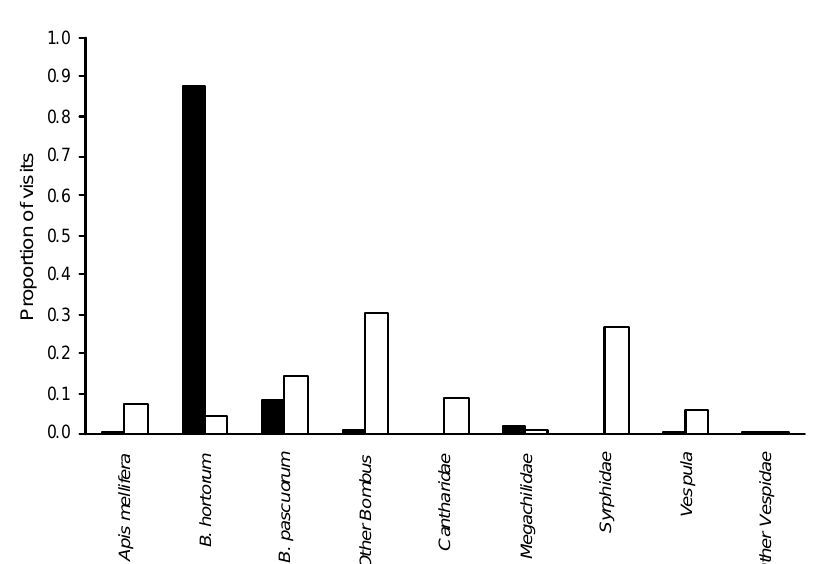
F IGURE . 2. Comparison of proportion of visits by insect taxa to flowers of Digitalis purpurea (black columns) and to flowers of other plant species on control transects within 15 m of the focal patches of D. purpurea (white columns). Data from woodland and non-woodland habitat have been pooled. Total numbers of insect visits were 1682 to D. purpurea and 1133 to flowers on control transects. Figure is illustrative, with statistical analysis (chi- squared test) being conducted on corrected numbers of visits as described in 'Materials and methods' and reported in 'Results'. Other Bombus consisted of B. hypnorum , B. lapidarius , B. pratorum , B. terrestris / B. lucorum (pooled) and B. ( Psithyrus )